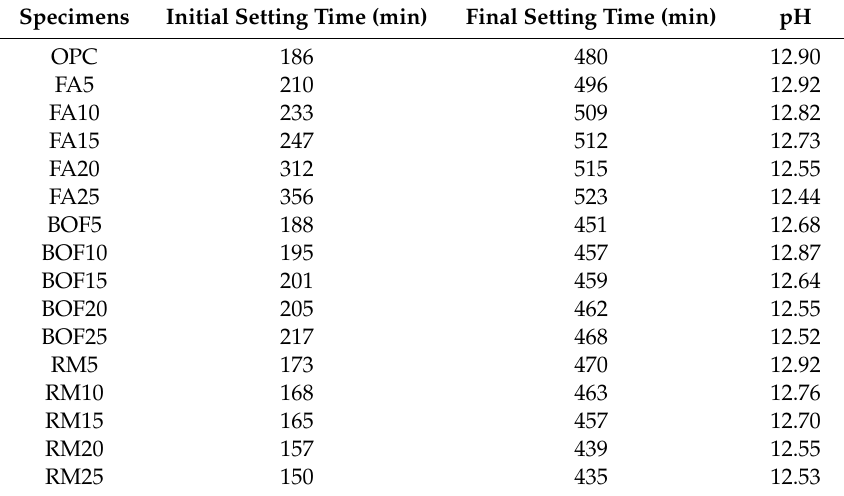
Table 3. Setting time and pH results for di ff erent